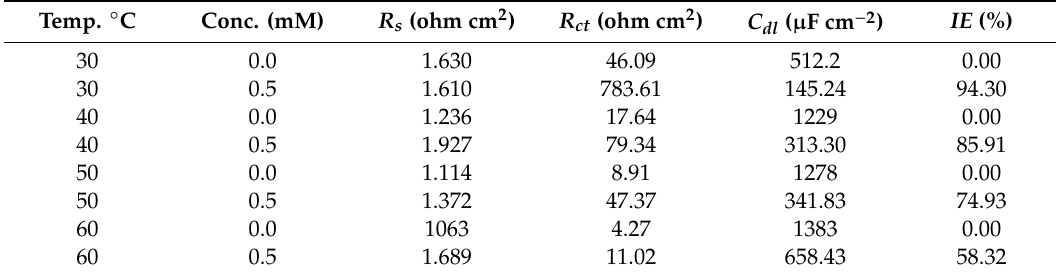
Table 2. CPE matching data for MS with 0.5 mM of inhibitor in 1N H 2 SO 4 at various temperatures. Temp. °C